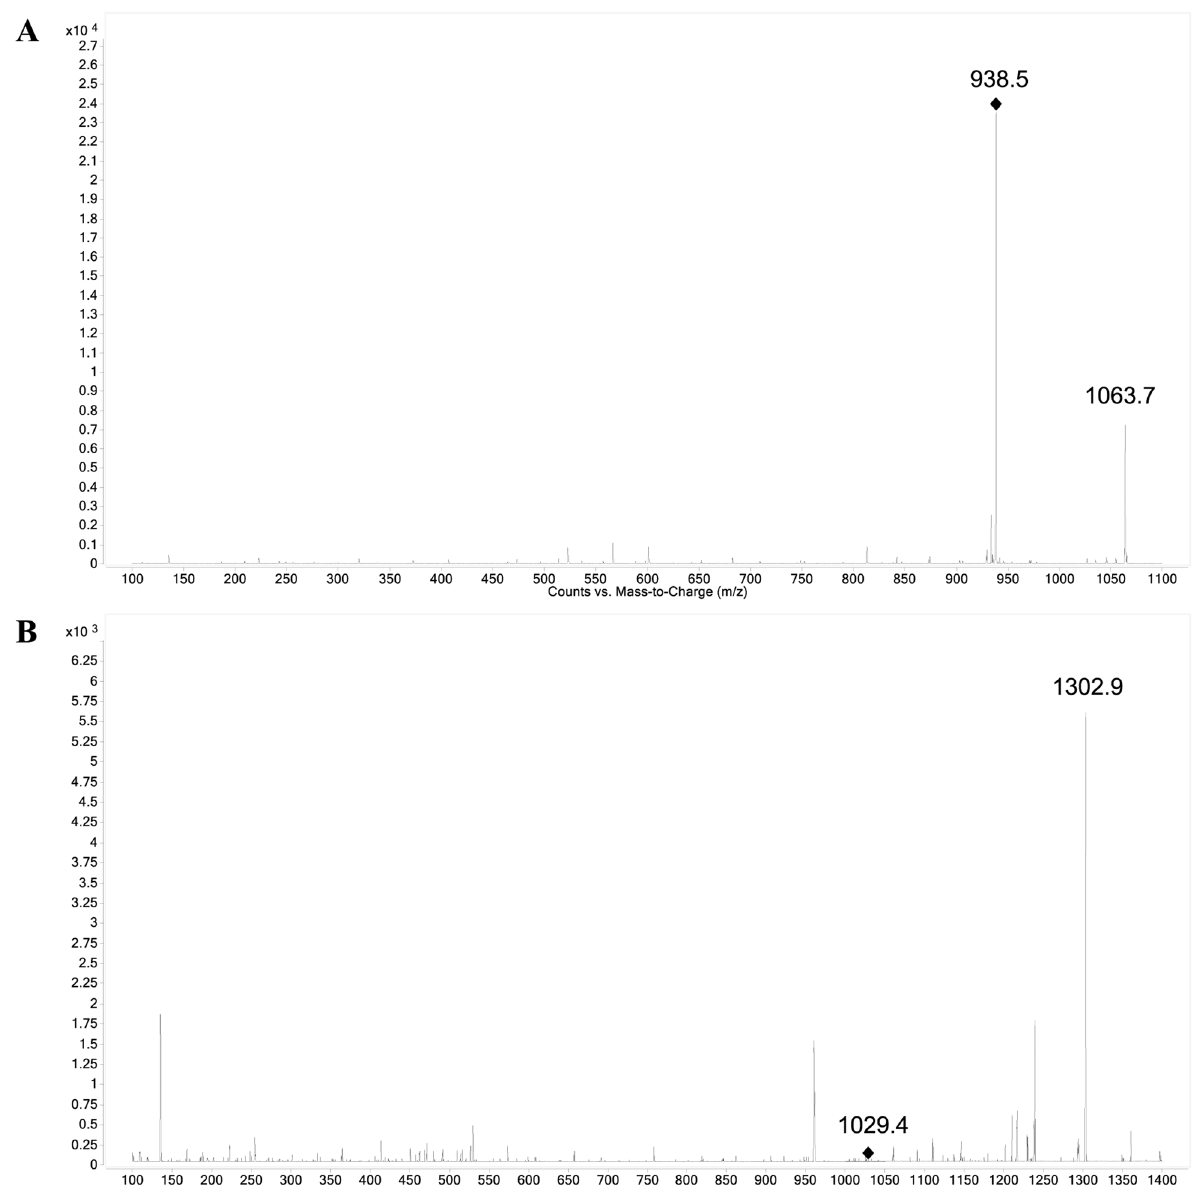
Fig. 1 Product ion spectra of protonated A liraglutide ([M